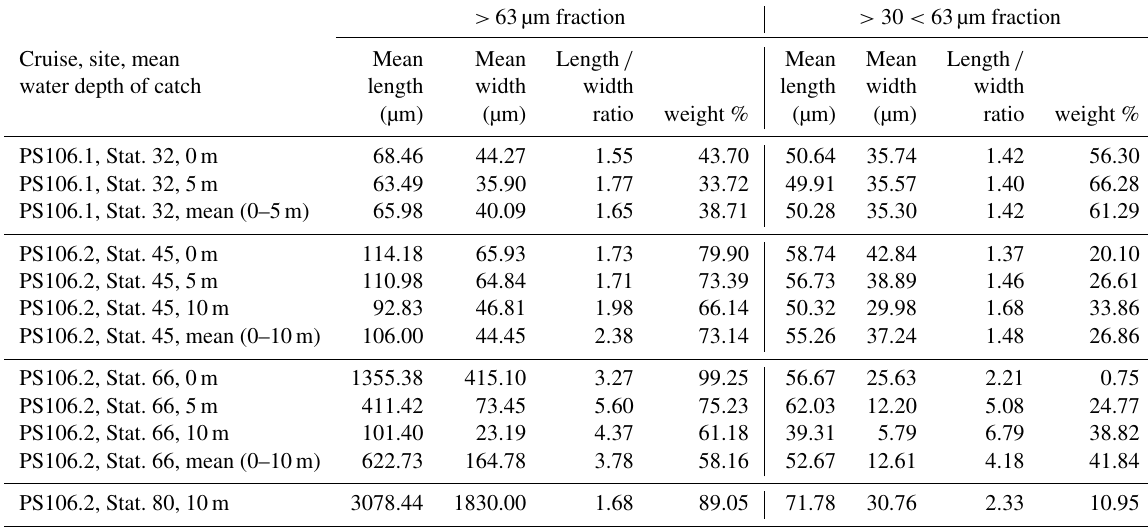
PS106.2, Stat. 80, 10m